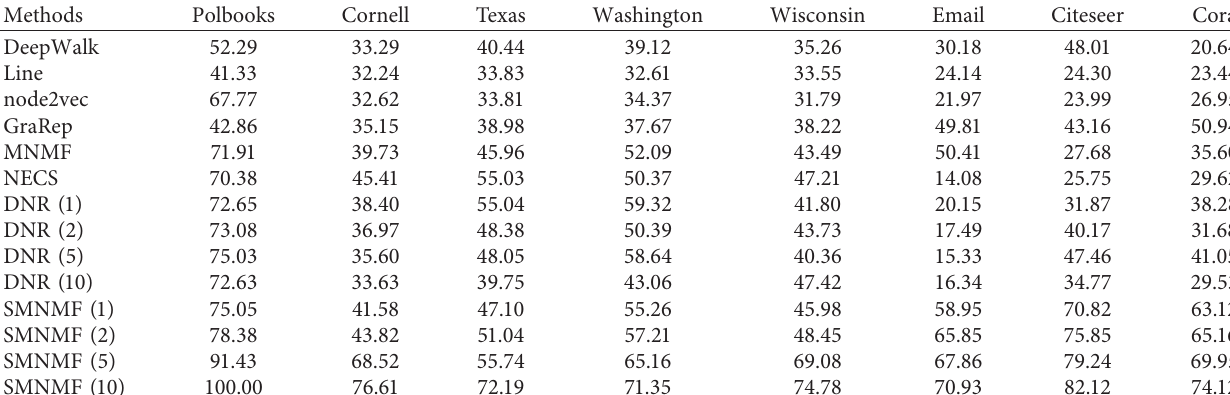
Table 3: Accuracy (%) of node